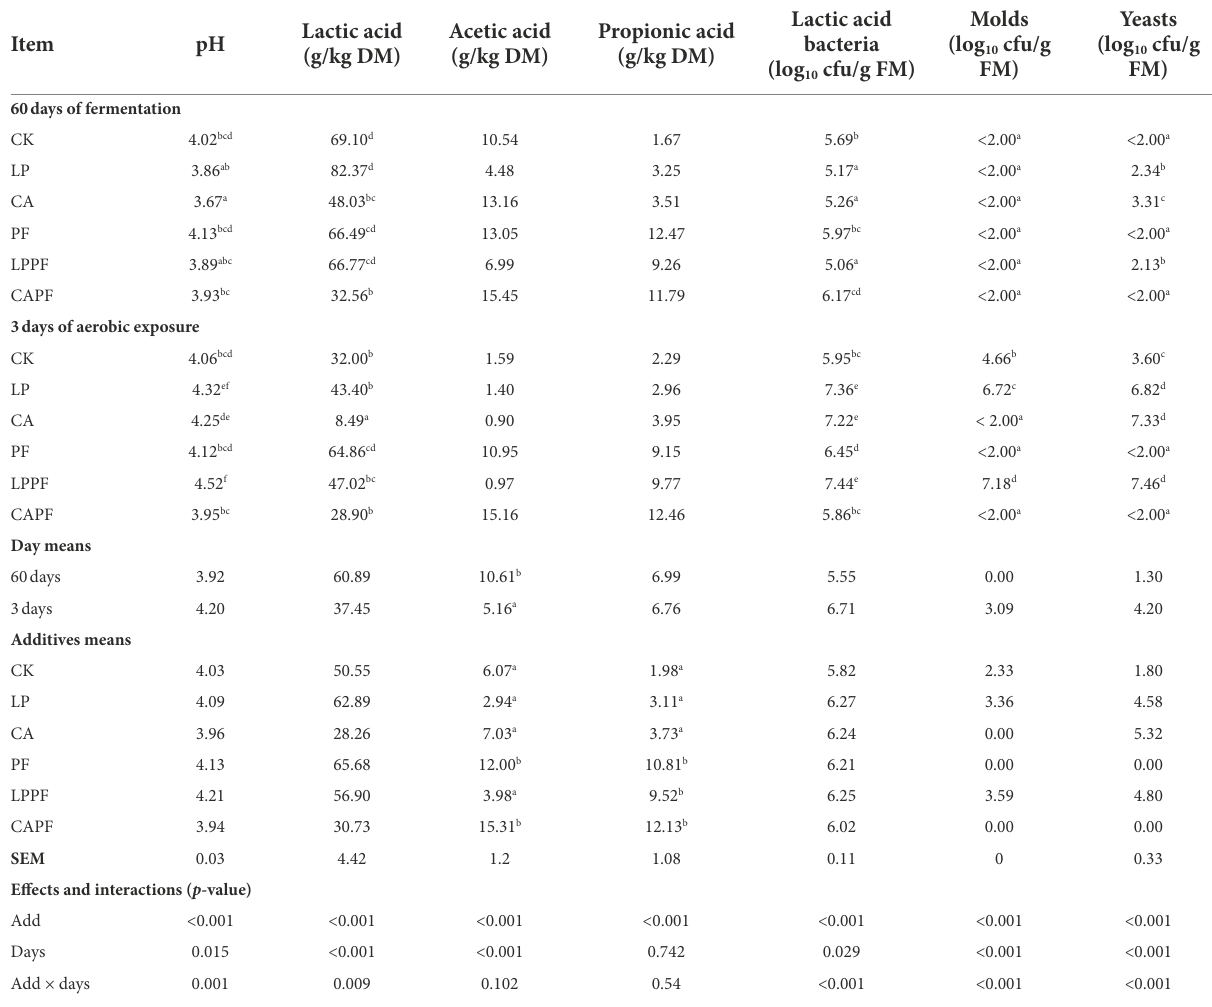
TABLE 2 Fermentation characteristics and microbial counts of forage oat silages during aerobic exposure.